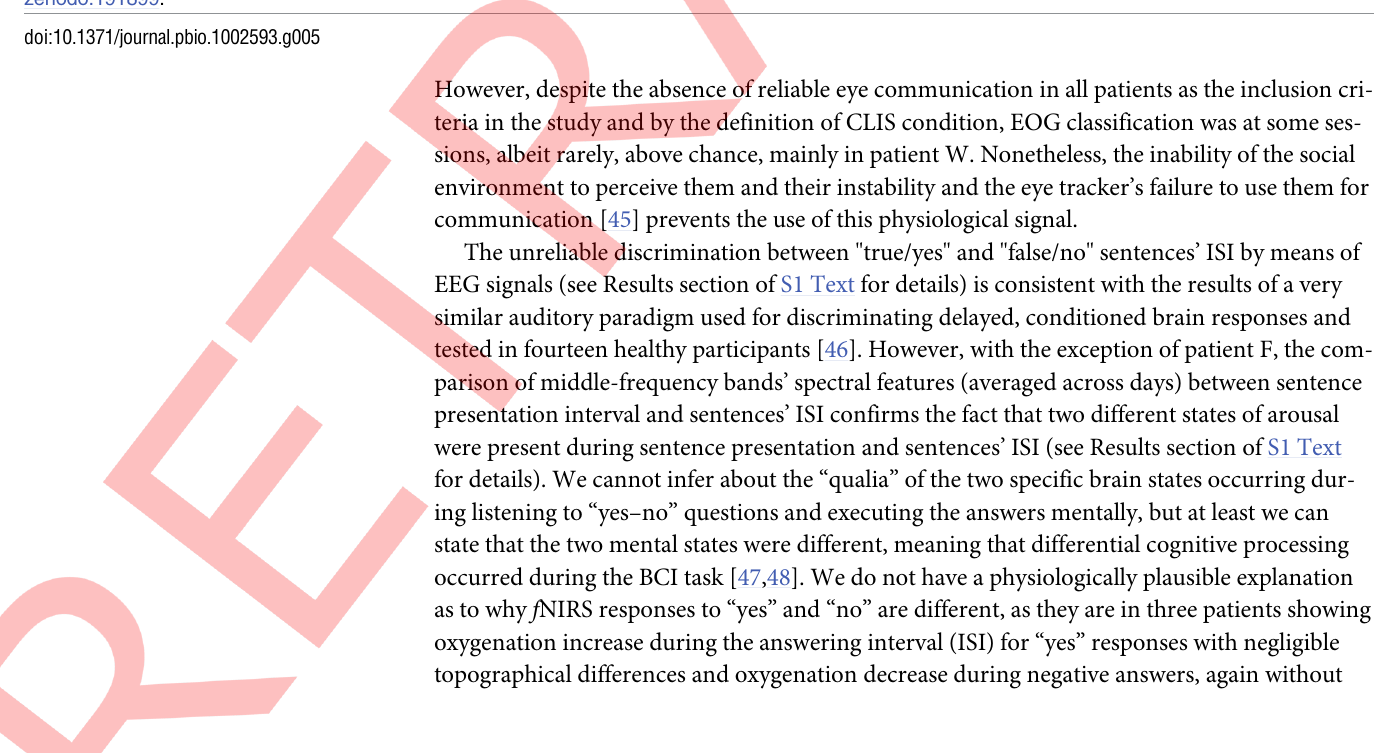
Fig 5. Classification accuracyof Patient W. The description of this figure is the same as describedin Fig 2. Fig 5 data is locatedat https://doi.org/10.5281/